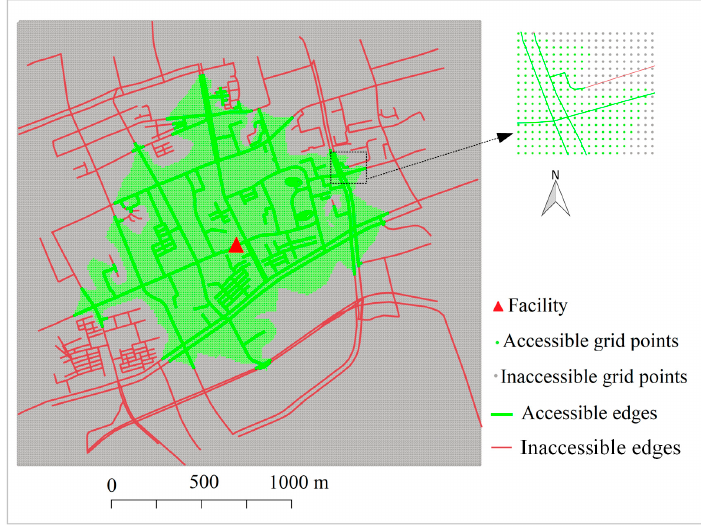
Figure 7. Illustration of accessible and inaccessible points within the searching